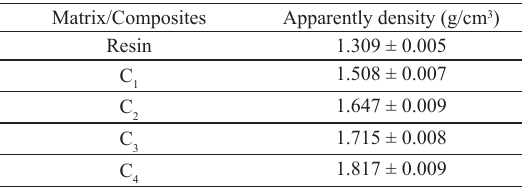
Table 4. Results of the apparent density tests for the composites and the polyester resin. Matrix/Composites